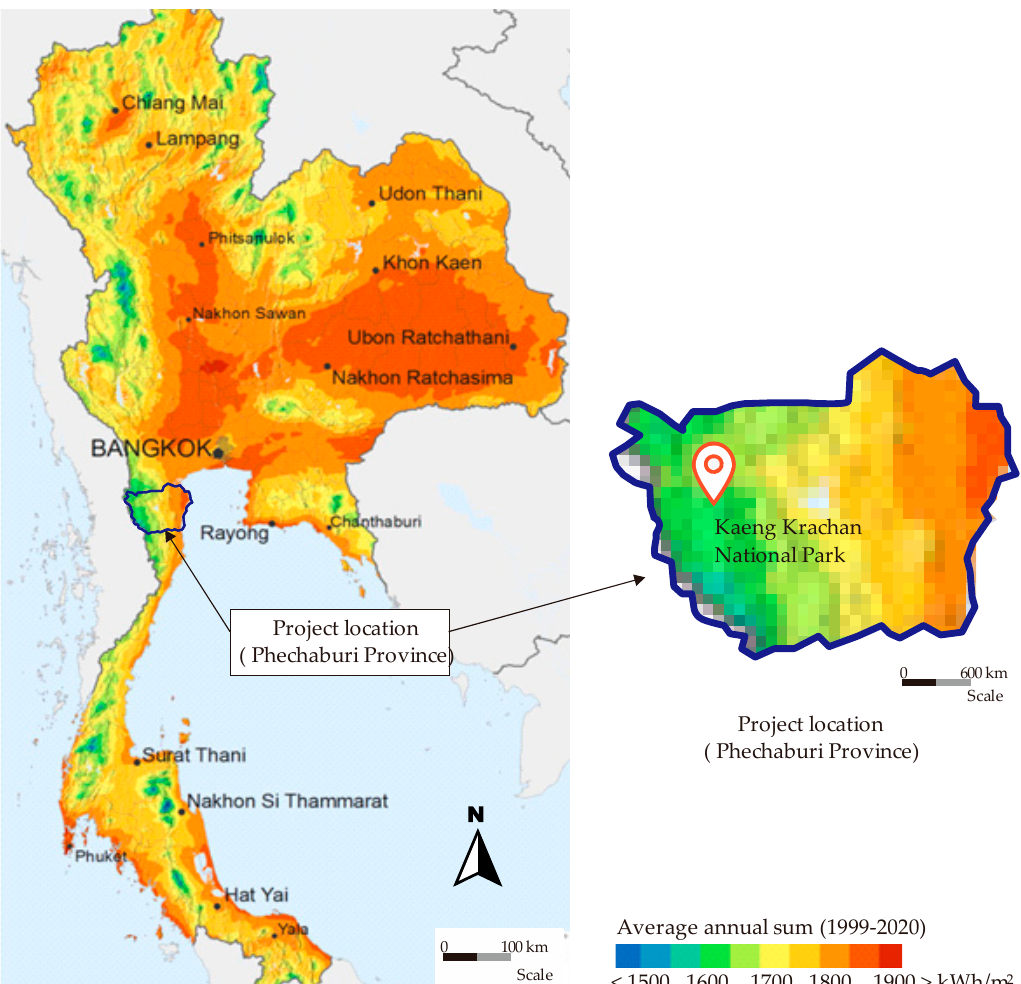
Figure 2. Horizontal solar radiation map of Thailand and Phechaburi province [37].